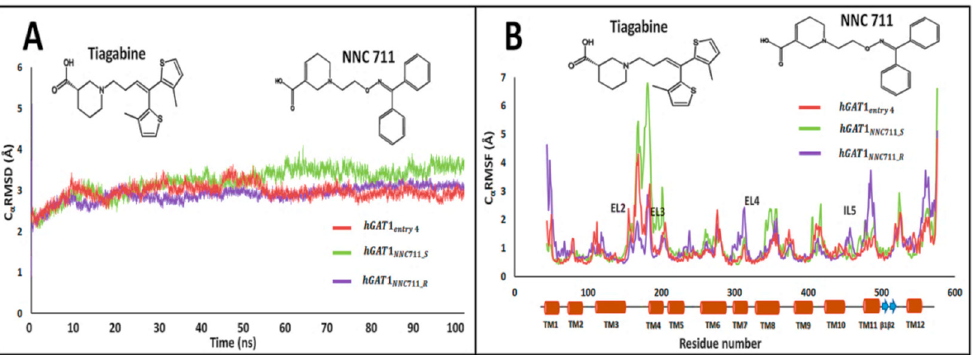
Figure 7. Cross validation of selected tiagabine enantiomer with C α RMSD of NNC711 enantiomers through MD simulations. ( A ) hGAT1 NNC711_R and hGAT1 entry 4 complexes showed the lowest C α RMSD (approx. 2.5–2.7 Å) ( B ) C α RMSF for the fluctuations of individual residues showed the significant loss of conformational stability specifically in EL2 region of hGAT1 (between TM3 and TM4, residue number 100 to 200).